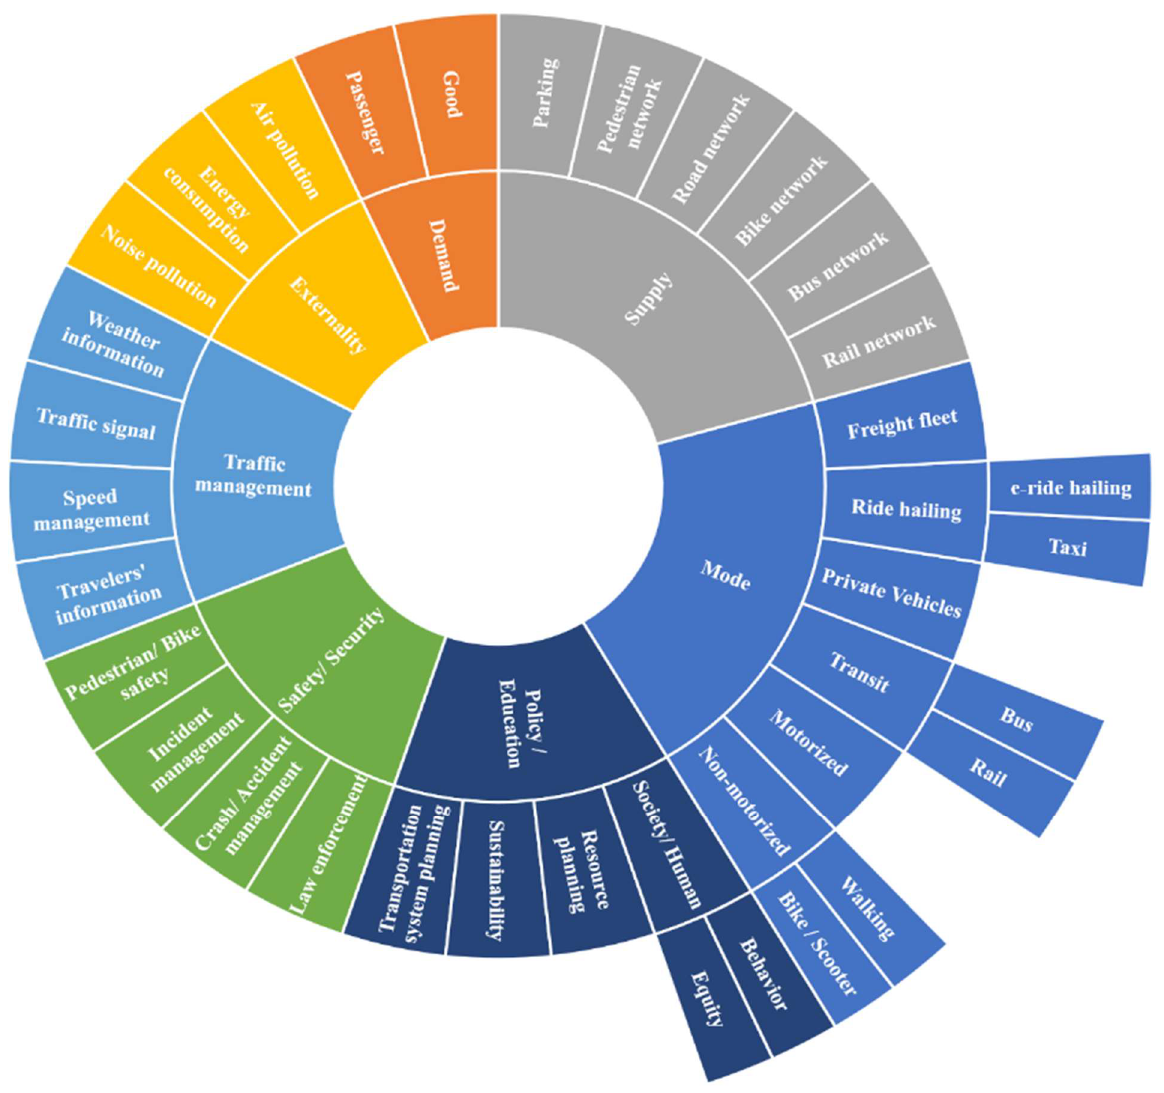
Figure 5. STS ecosystem component dynamics.